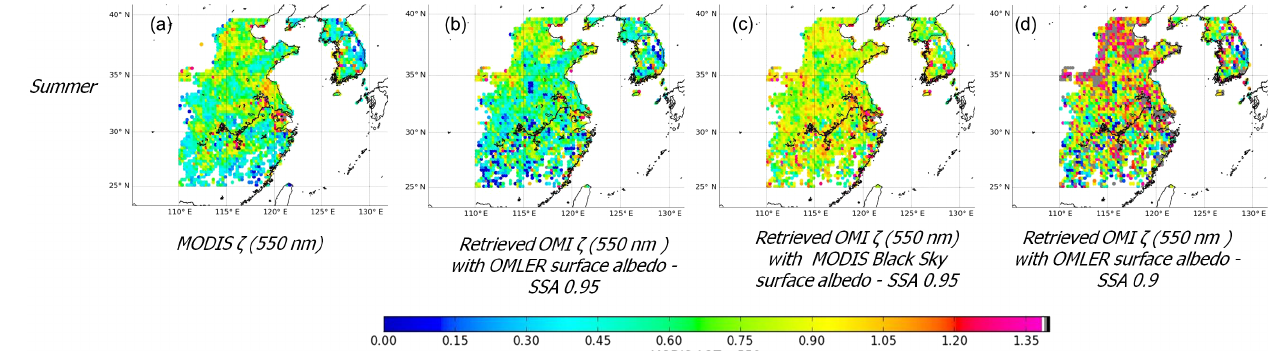
Figure 13. Spatial averages of τ (550nm) values over north-east Asia for cloud-free scene. Statistics are computed over 3 years, 2005–2007, for summer.